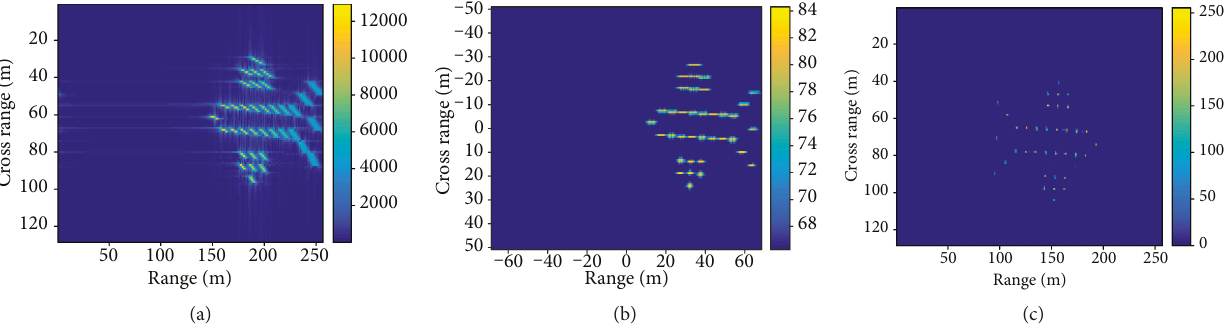
Figure 7: Imaging results with the target ’ s motion parameters P4. (a) RD algorithm. (b) Keystone transform. (c) The proposed method.